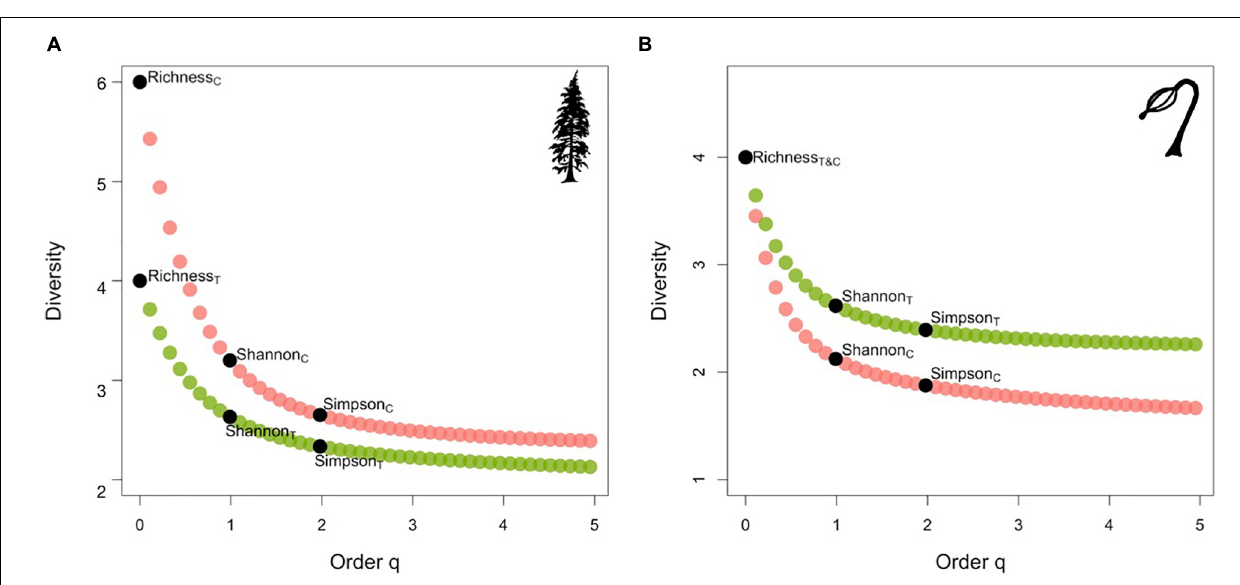
test results regarding the three quantiles analysis which only considered quantiles one and two. Tree height data for five habitation sites and four control sites were modeled against